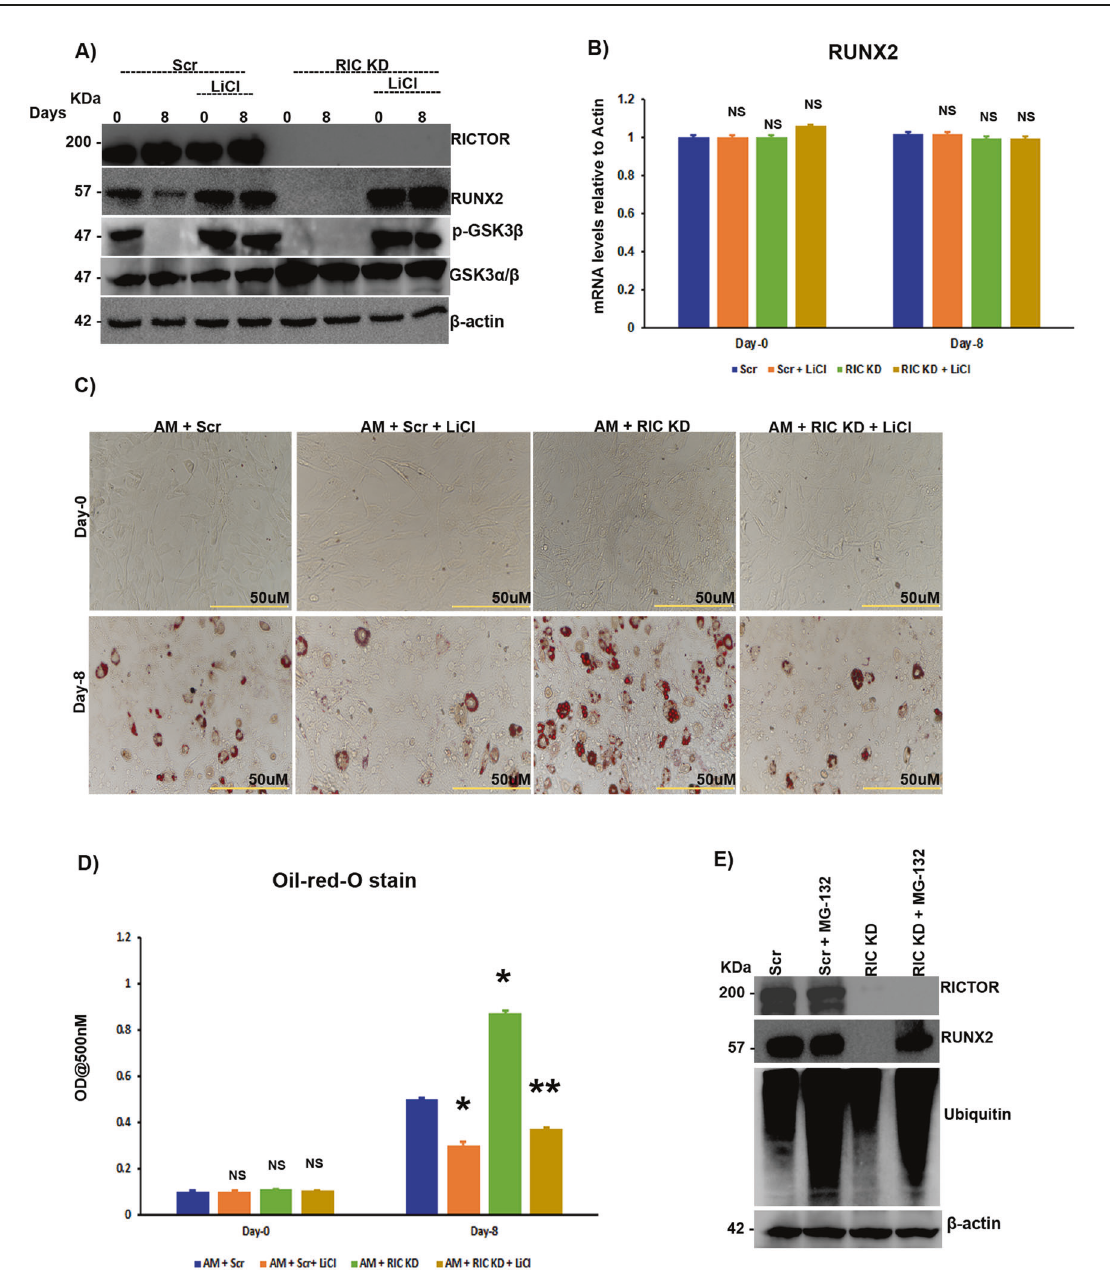
Fig. 3 mTORC2 stabilizes RUNX2 through the AKT-473/GSK3 β axis. Murine MSCs (C3H10T1/2) were treated with LiCl (0.5 mM) with or without siRNA against rictor, along with adipogenic induction and A subjected to Western blot analysis and B RT-PCR as indicated. C Oil red O-stained images of murine MSCs (C3H10T1/2) treated with LiCl (0.5 mM) with or without siRNA against rictor, along with adipogenic induction as indicated and D quanti fi cation of oil red O staining by spectrophotometry. Murine MSCs (C3H10T1/2) were transfected with siRNA against rictor in the presence or absence of MG-132 for 48 h after transfection, and E Western blot analysis was performed after 48 h with the indicated antibodies. Mean ± S.E.M.; N = 3, * p < 0.1 versus control, ** p < 0.01 versus control, NS p > 0.1 versus control. AM adipogenic medium, Scr scrambled siRNA, RIC KD rictor knockdown with siRNA, LiCl lithium chloride, NS not signi fi